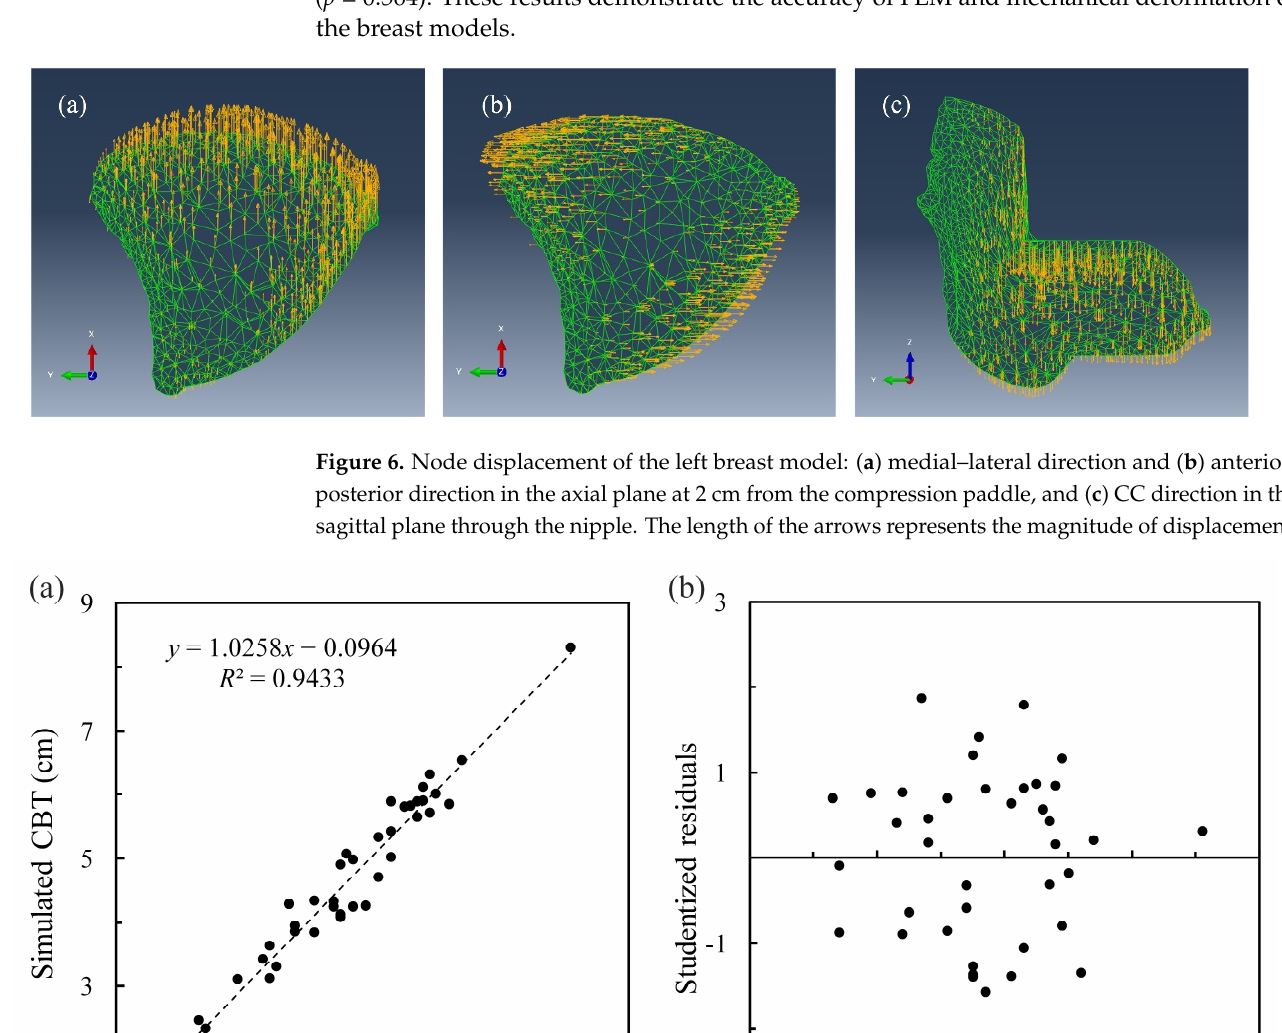
Figure 7. ( a ) Scatter plot of the simulated CBT and the clinical CBT at the same clinical compression force, and ( b ) the studentized residual plot as a function of clinical CBT. The residuals are scattered throughout the clinical CBT without showing any clear trend.